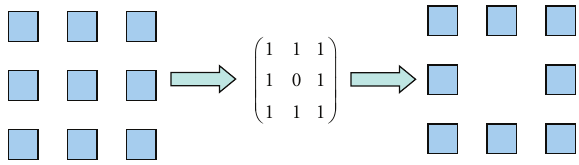
Figure 2: Illustration of the procedure for converting a 3 × 3 planar array to the first level ( P = 1) of Sierpinski carpet